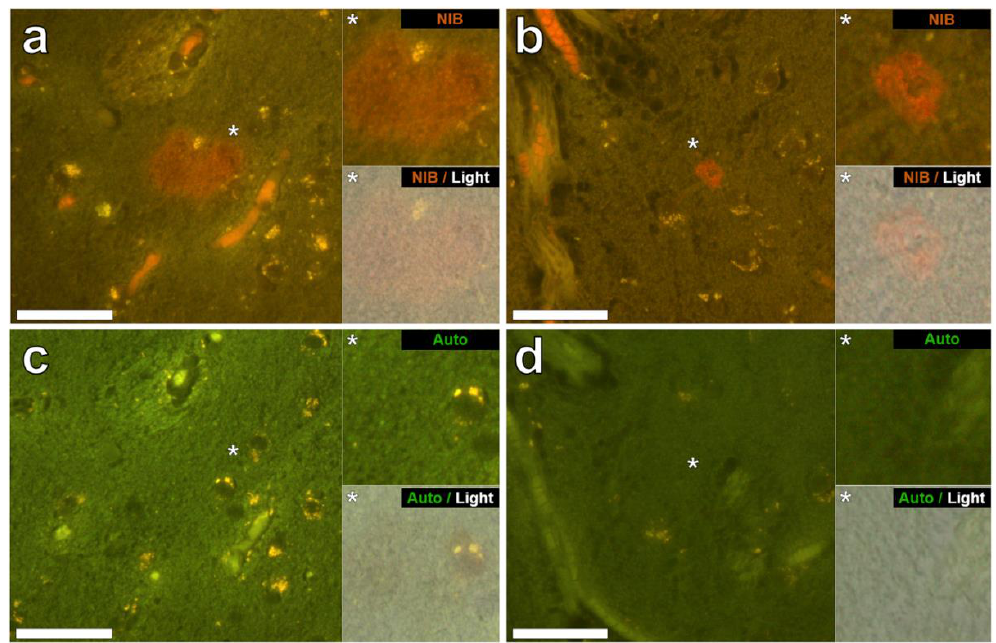
Figure 4. Extracellular aluminium in close-proximity to the temporal lobes of a 56-year-old male donor (MS274) and a 48-year-old female donor (MS317), diagnosed with RRMS and SPMS respectively. ( a ) Diffuse extracellular aluminium fluorescence in the basal ganglia of the male donor spanning ~50 μm in diameter (grey matter). ( b ) Extracellular deposits of aluminium in the medial temporal region of the female donor (grey matter). Autofluorescence of serial sections ( c , d ) confirms the identity of aluminium in ( a,b ) respectively. Upper and lower panels depict magnified inserts of the fluorescence channel and bright field overlay. Magnification ×400, scale bars: 50 μm.